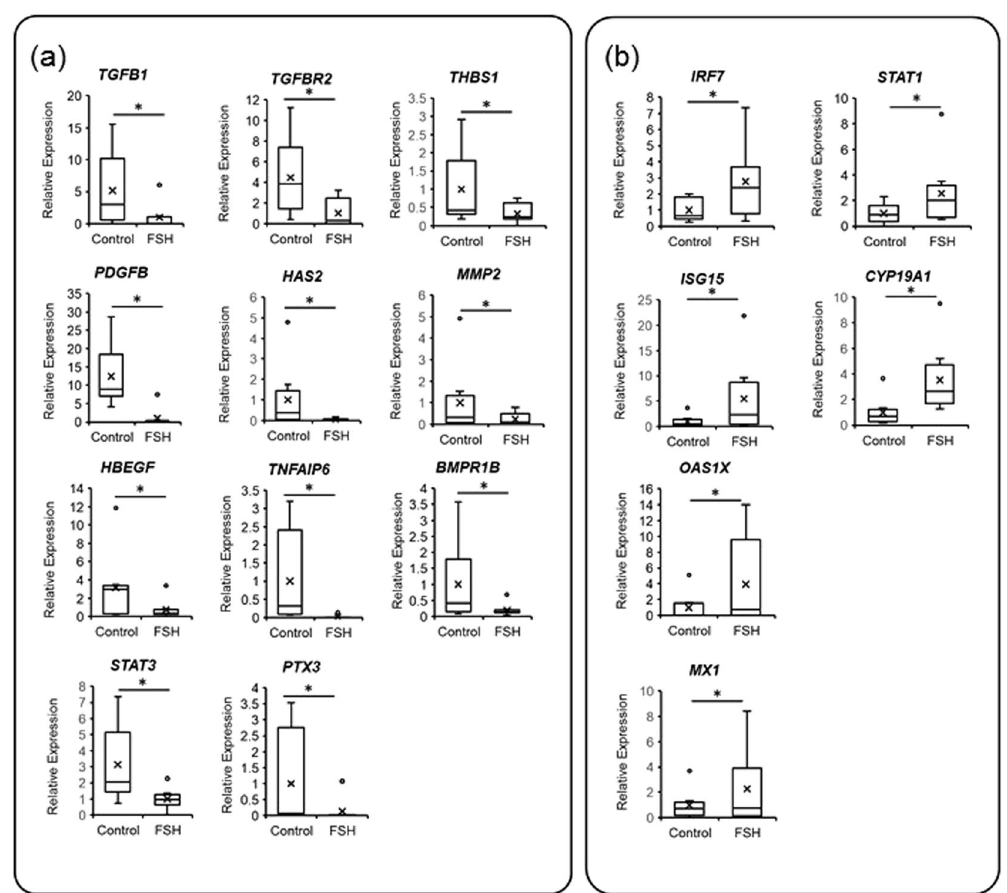
Figure 5. Validation of RNA-seq results by qPCR. Selected down-regulated ( a ) and up-regulated FSH-priming- sensitive genes ( b ) in bovine cumulus cells are shown. mRNA expression levels in the cumulus cells derived from eight donor cows without (control) or with FSH-priming (FSH) are represented as a box-and-whisker plots. Boxes reflect two quartiles, the 25th and 75th percentiles, and the interior horizontal line indicates the median. Whiskers indicate the maximum and minimum values within the acceptable range defined by the two quartiles. Open circles denote outliers. Crosses indicate mean value. Asterisks indicate significant difference at P < 0.05. TGFB1 , transforming growth factor beta 1; PDGFB , platelet-derived growth factor subunit B; HBEGF , heparin-binding epidermal growth factor-like growth factor; STAT3 , signal transducers and activator of transcription 3; TGFBR2 , transforming growth factor beta receptor 2; HAS2 , hyaluronan synthase 2; TNFAIP6 , tumour necrosis factor, alpha-induced protein 6; PTX3 , pentraxin 3; THBS1 , thrombospondin 1; MMP2 , matrix metalloproteinase 2; BMPR1B, bone morphogenetic protein receptor type 1B; IRF7 , Interferon regulatory factor; ISG15, interferon-stimulated gene 15; OAS1X , 2 ′ -5 ′ -oligoadenylate synthetase 1, 40/46 kDa; MX1 , interferon-induced GTP-binding protein; STAT1 , signal transducers and activator of transcription 3; CYP19A1 , cytochrome p450 family 19 subfamily a member